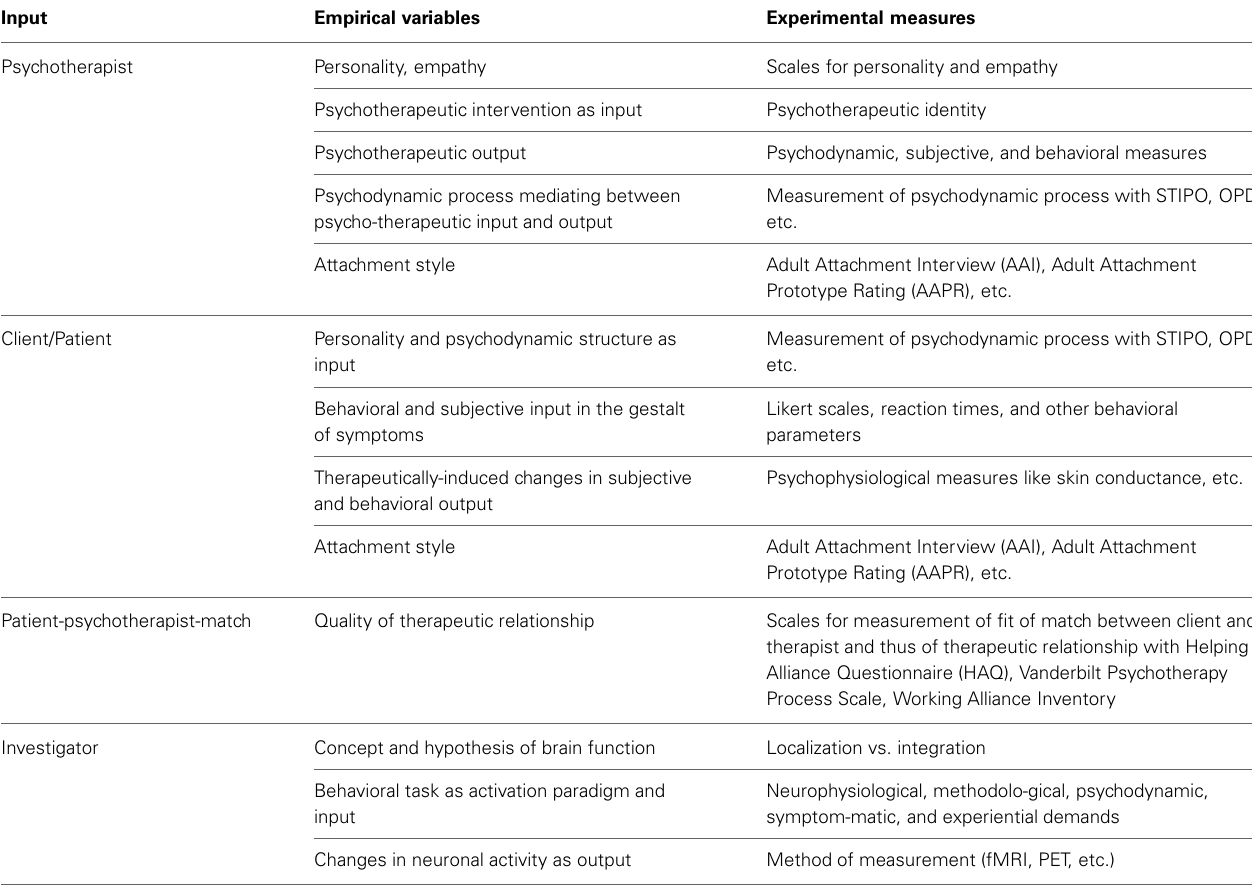
Table 1 | Input, empirical variables, and experimental